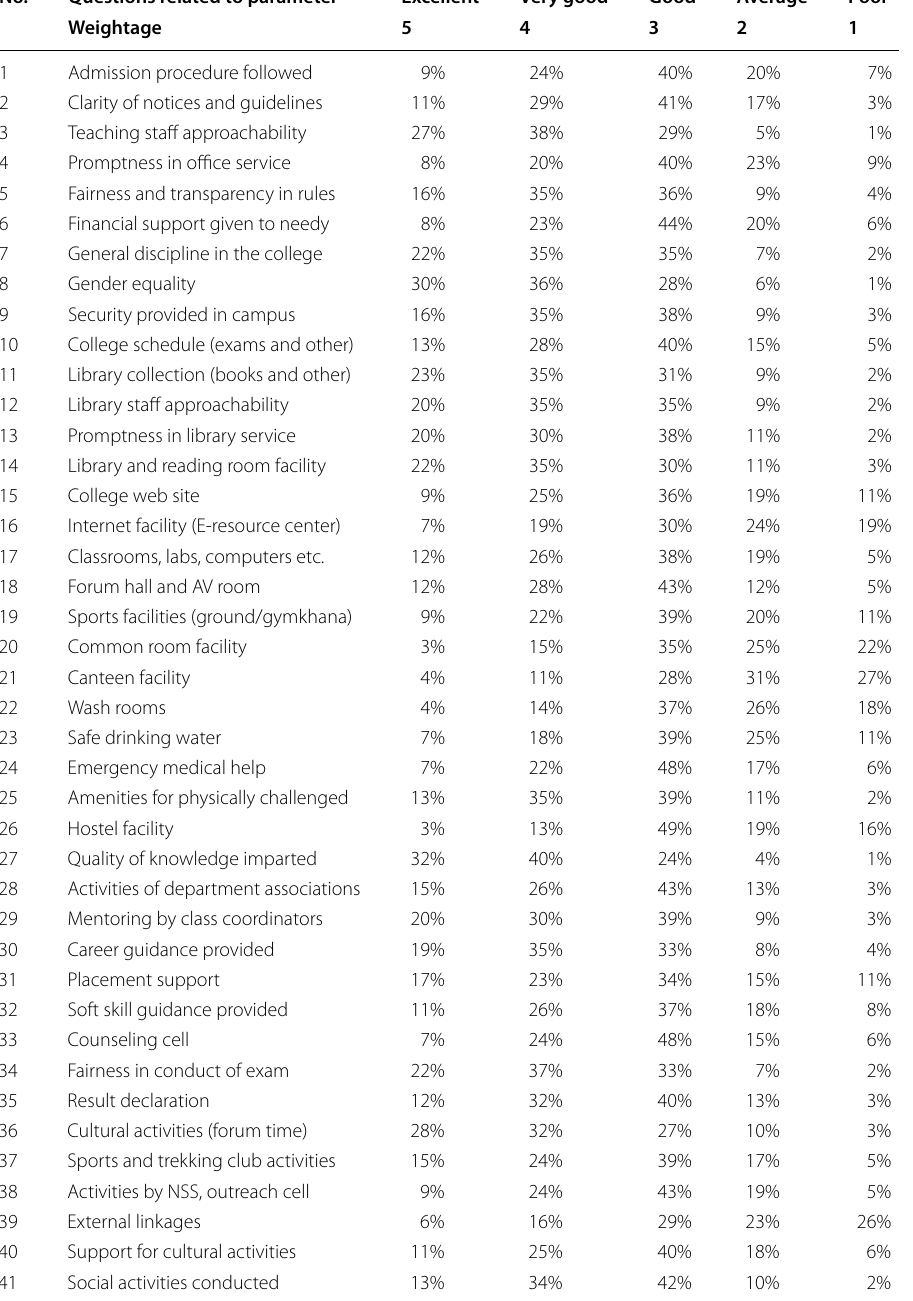
Table 1 Responses obtained from the students on 5-point scale